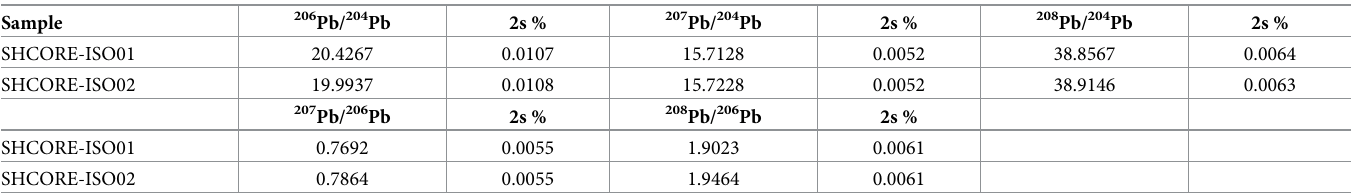
Table 8. Pb isotope composition and uncertainties for the whole-rock samples.